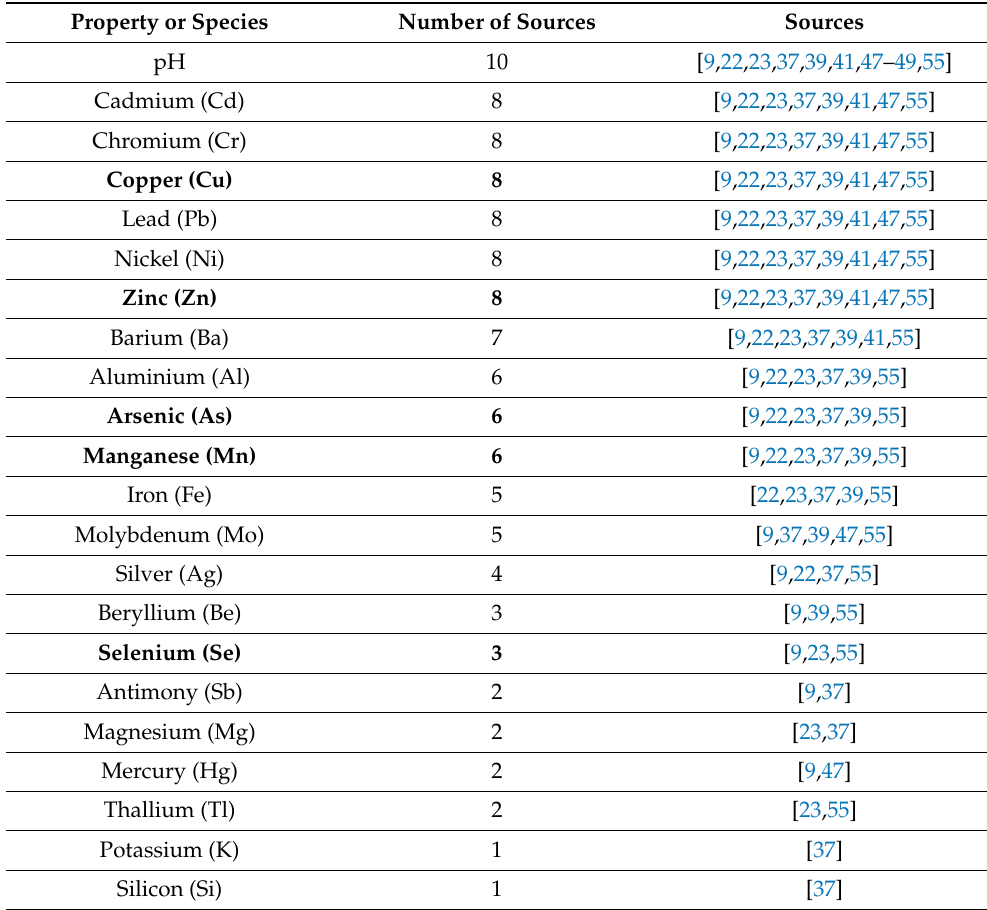
Table 3. Chemical properties reported in the experimental RAP literature, and the number of studies that reported each property. Bolded parameters exceeded allowable limits in some studies. Property or Species Number of Sources Sources pH